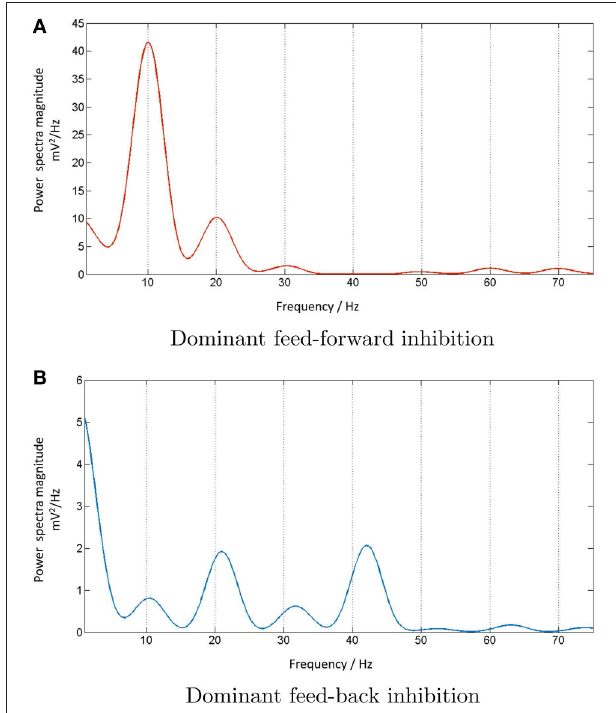
FIGURE 9 | (A) The power spectral density plot corresponding to 10Hz periodic input to the multi-node LGN model implies entrainment of the model response when the IN is dominant in the circuit. However, the output loses the fidelity when (B) the IN is suppressed in the circuit and the TRN inhibition is dominant. The dominant frequency is now at twice the fundamental frequency and reflects the frequency traits of the dominant TRN inhibition in the circuit (not